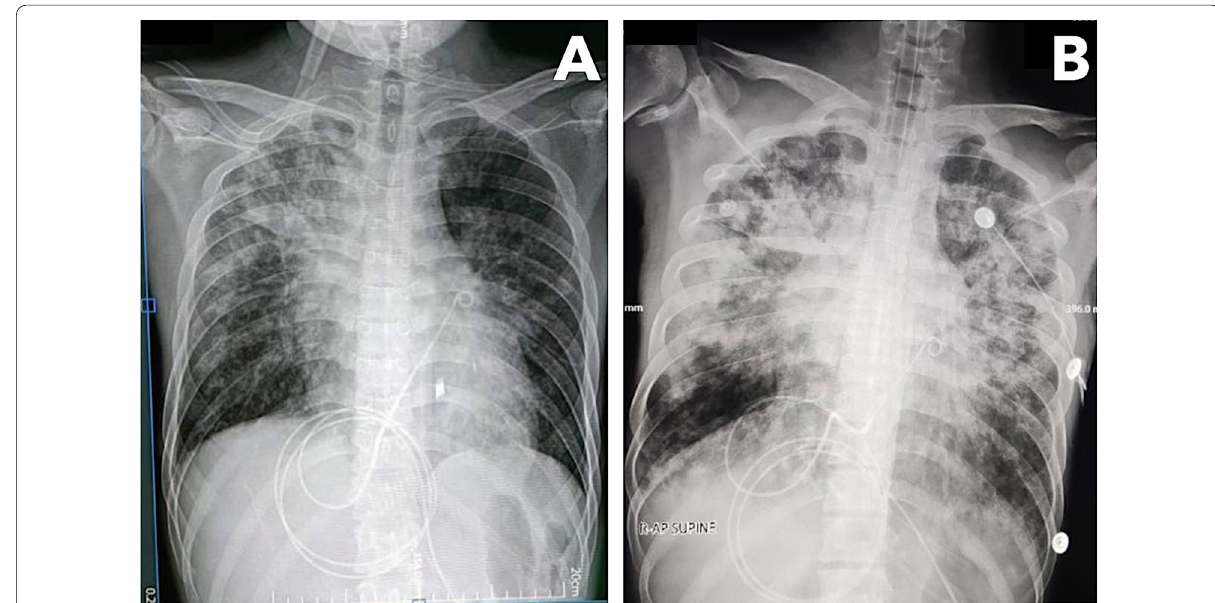
Fig. 4 Chest radiographs taken after pericardiocentesis with visible reduction in the size of the cardiac silhouette ( A ) and taken 12 days after with progression of air bronchograms and fibroreticular infiltrates in both lung fields ( B )